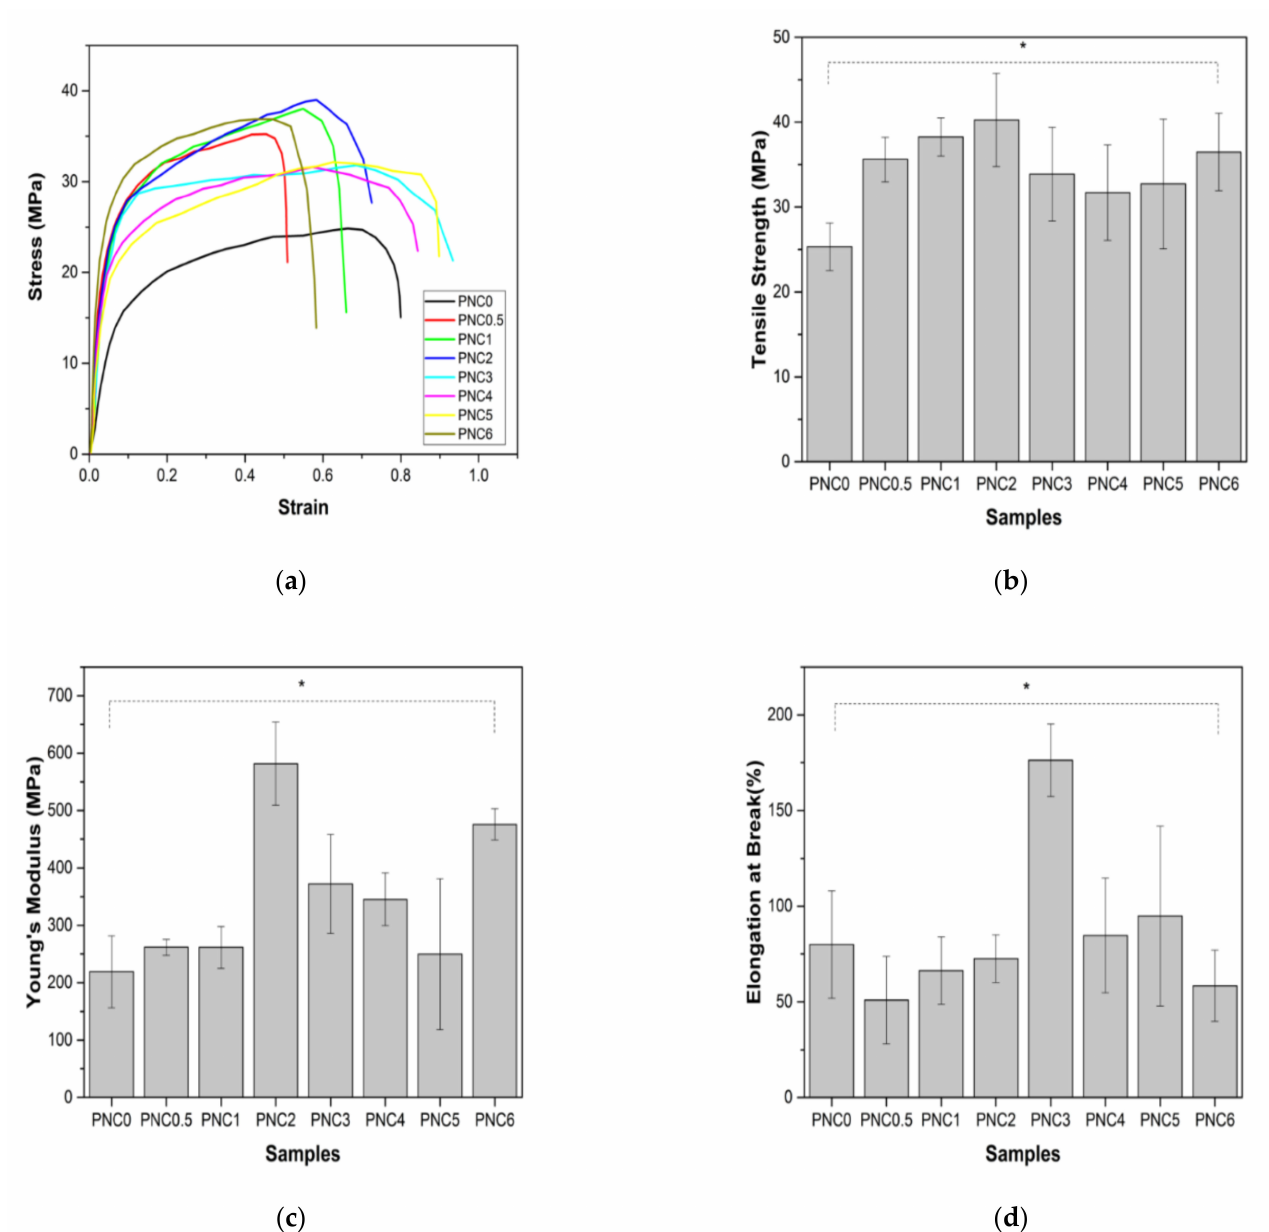
Figure 10. ( a ) The representative stress–strain curves of PVA–NCC nanocomposite films, ( b ) tensile strength, ( c ) Young’s modulus, and ( d ) elongation at break of PVA–NCC nanocomposite films (*: p <